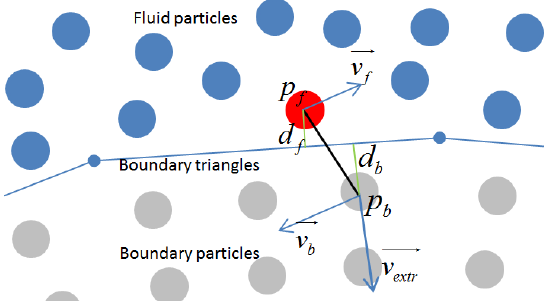
Figure 5. Construction of an artificial velocity for boundary